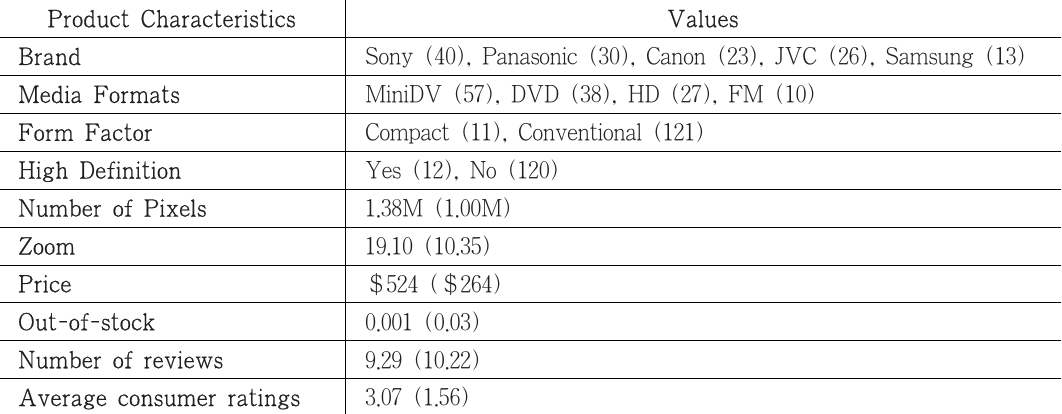
<Table 1> Summary statistics of products in the empirical analysis. Mean and standard deviations for continuous variables are computed across products (J=131) and periods